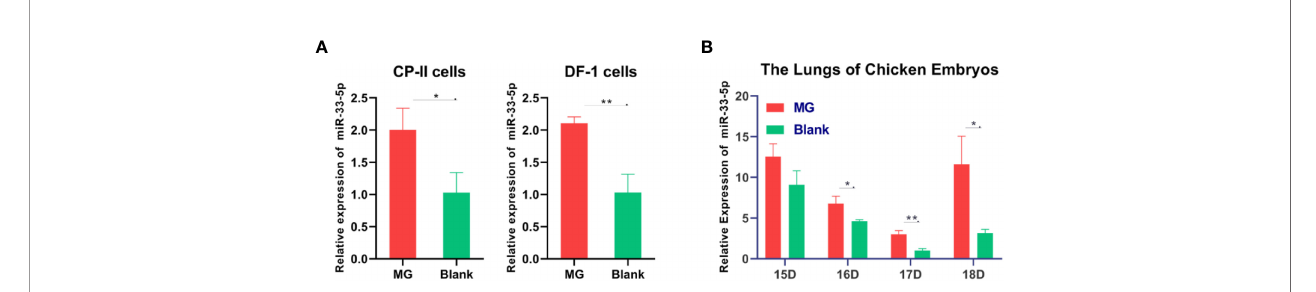
FIGURE 1 | Relative miR-33-5p expression level in MG-infected cells and chicken embryonic lung tissue. (A) The relative level of miR-33-5p in MG-infected DF-1 cells and CP-II cells. Cells cultivated in 6-well culture dishes were treated with MG. After 24h treatment, total RNA of infected cells were extracted using TRNzol Universal. The level of miR-33-5p-infected cells was detected by qPCR; (B) The relative level of miR-33-5p in MG-infected chicken embryo lungs. Total RNA were extracted from infected chicken embryo lungs on days 6-9 post-infection (equivalent to days 15-18 of eggs hatching) using TRNzol Universal. Then, the level of miR- 33-5p in MG infected embryo chicken lungs was determined through qPCR. Above data was corrected via 5s-RNA as the internal quantitative control gene. All measurements shown were the mean ± SD from three independent experiments, each with three replicates. (* p < 0.05, ** p < 0.01).